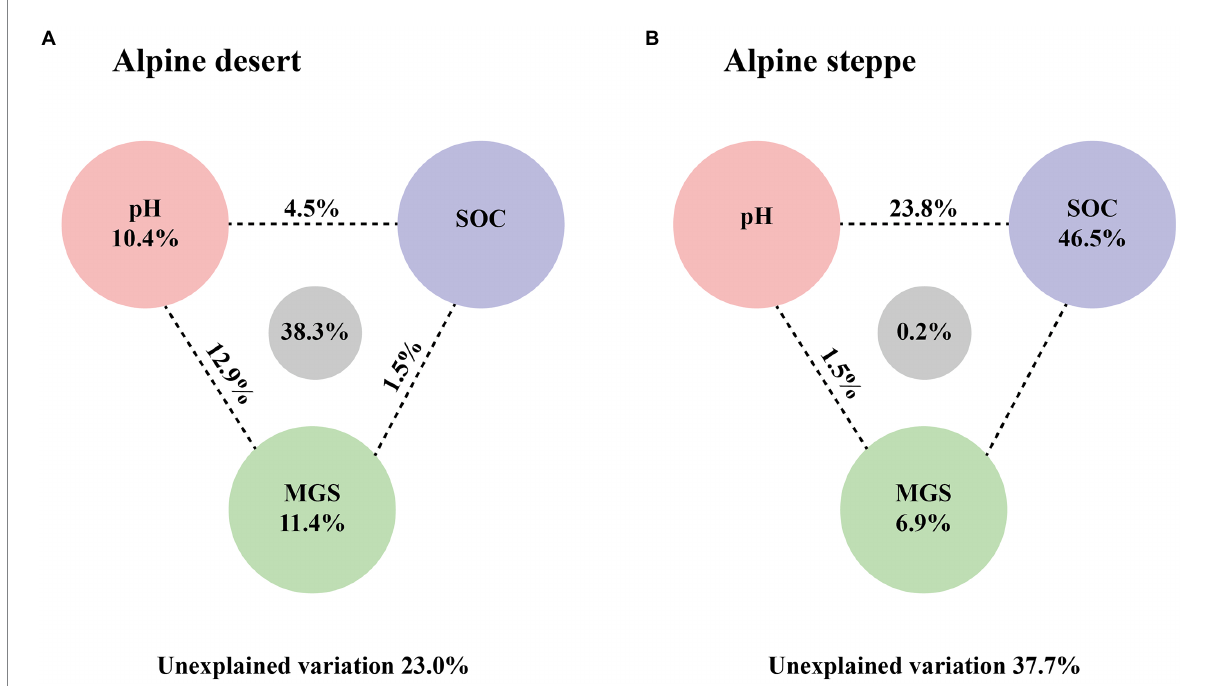
FIGURE 6 Variation partitioning analysis (VPA) for bacterial PLFAs in the alpine desert (A) and in the alpine steppe (B) . The numbers between the circles indicate the intersections between the two types of variables on either side.